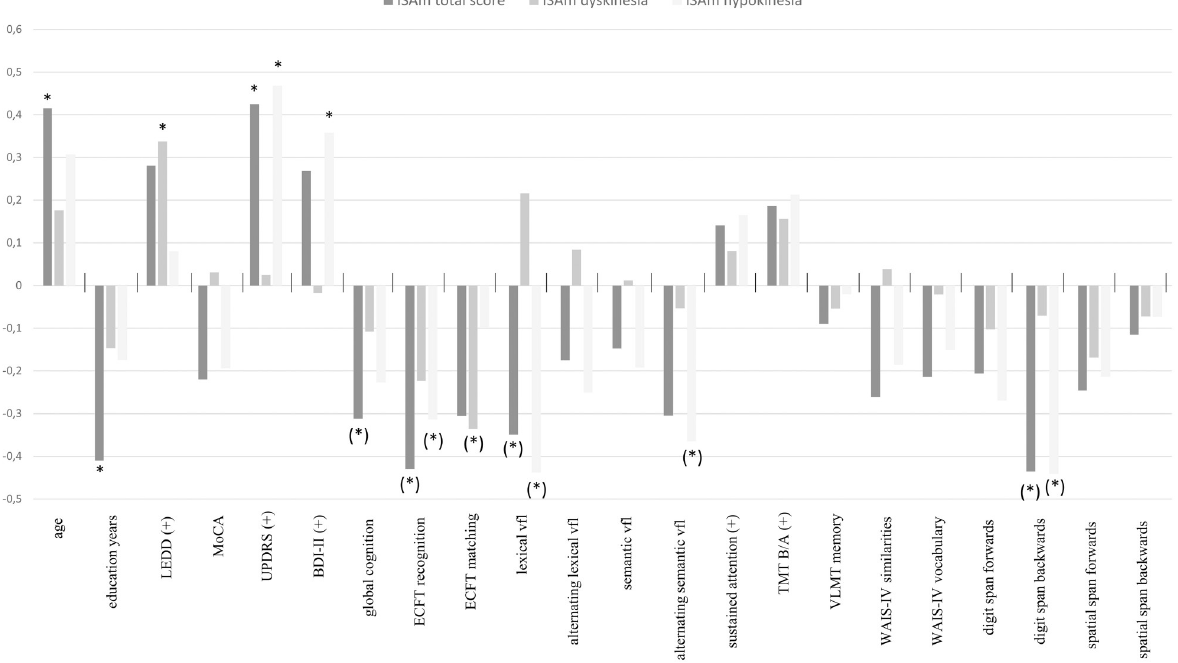
Fig 1. Spearman correlations between ISAm and demographic, disease-related and neuropsychological data. Abbreviations: BDI-II, Beck Depression Inventory; ECFT-MI, Extended Complex Figure Test–Motor Independent Version; LEDD, levodopa equivalent daily dose; MoCA, Montreal Cognitive Assessment; TMT, Trail Making Test; VLMT, Verbal learning and memory test; WAIS-IV, Wechsler Adult Intelligence Scale– Fourth Edition; vfl, verbal fluency; (+), higher scores indicate higher impairment or worse performance; � p < .05; ( � ) p � .05 after correction for age and education